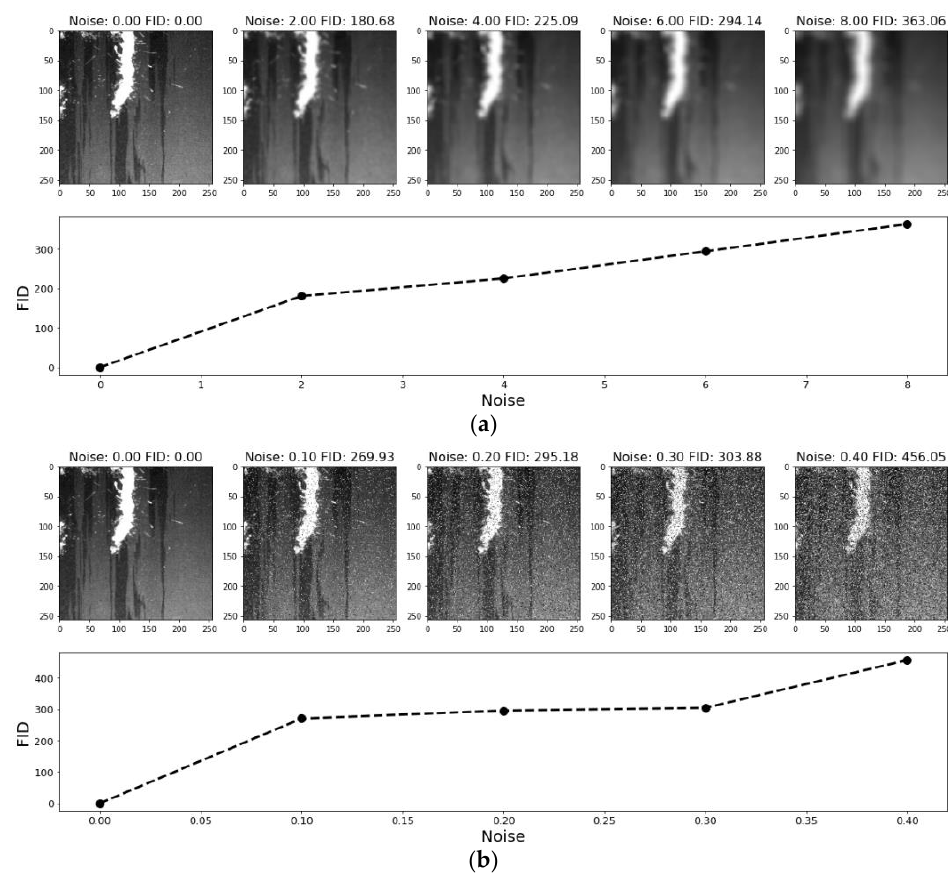
Figure 6. Example of Fréchet inception distance (FID) evaluation using steel defect images: descrip- tion of ( a ) Gaussian blur; ( b ) salt and pepper.